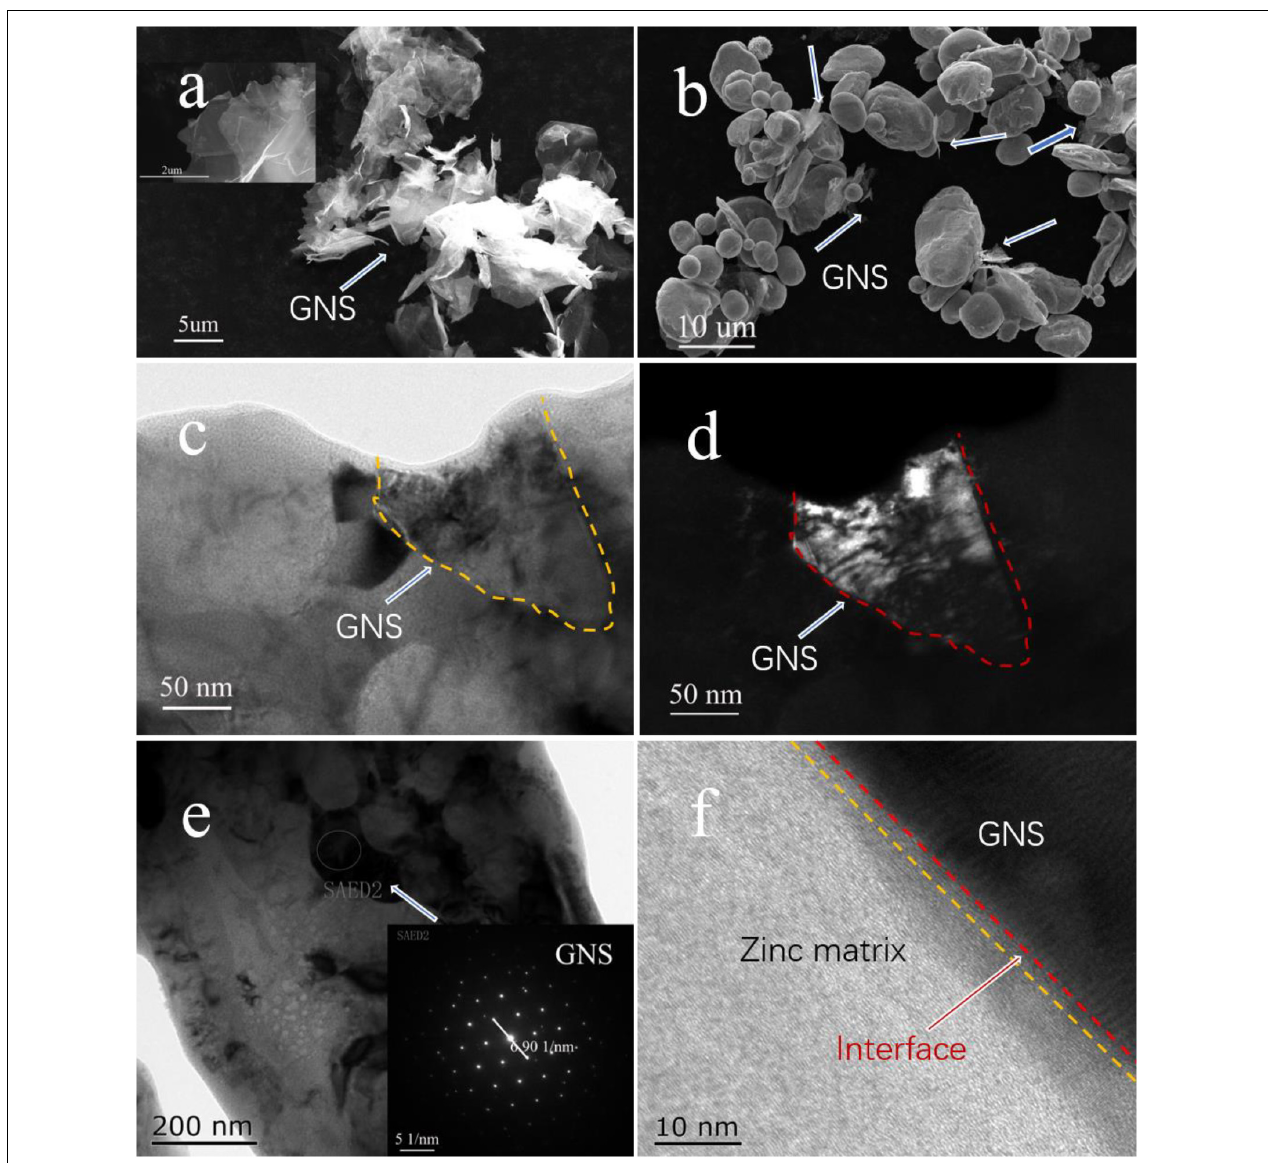
FIGURE 2 | (A) SEM image of GNS after chemical treatment, (B) SEM image of ball milled powder, (C,D) TEM bright-field and dark-field images of GNS/Zn composite material, (E) TEM image of GNS displayed in composite material (inset is GNS diffraction spot), (F) TEM of interface relationship between Zn and GNS.